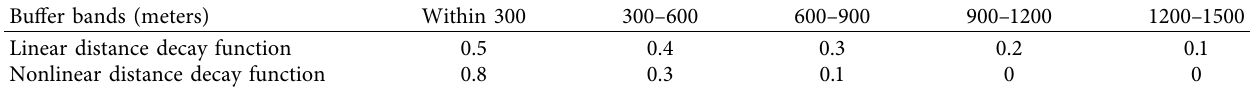
Table 2: The weights of each buffer